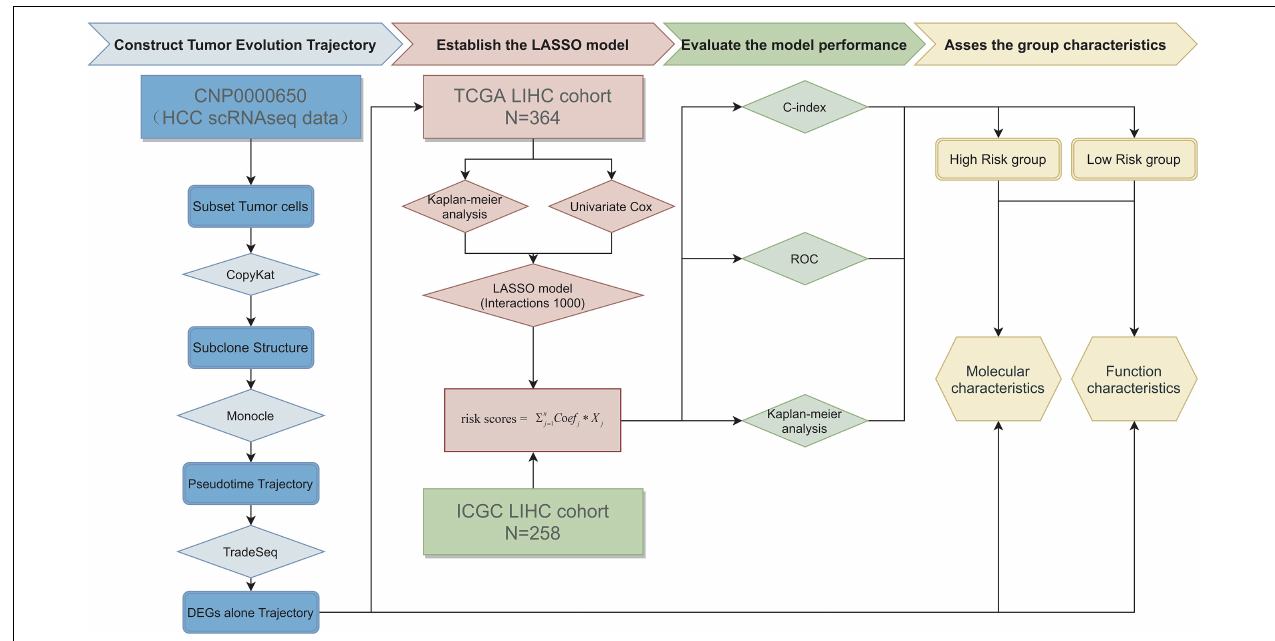
FIGURE 1 | The whole process of data